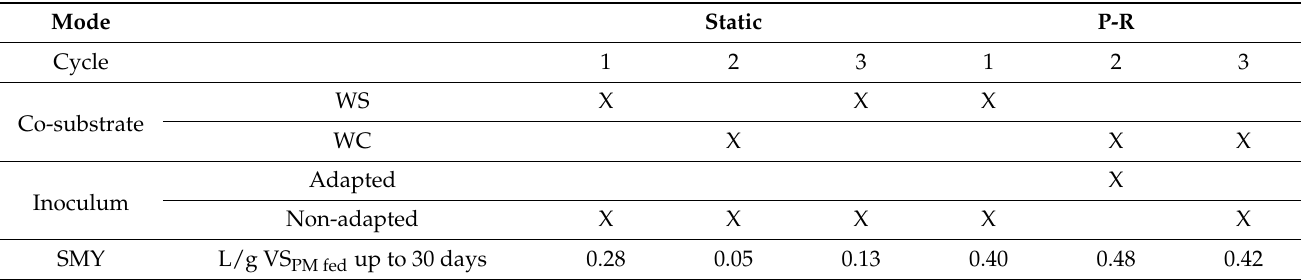
Table 5. Parameters considered to observe the effect of the adapted